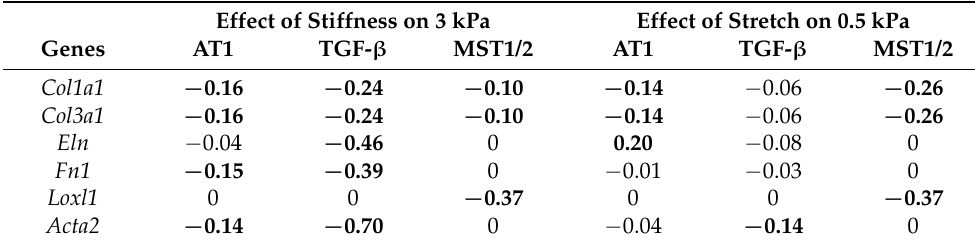
Table 2. Changes in gene expression due to inhibition of Angiotensin II Receptor Type I (AT 1 ), Transforming Growth Factor- β (TGF- β ), and Macrophage Stimulating 1 or 2 (MST1/2) receptors in response to stiffness and stretch. Numbers in bold indicate activity changes greater than a threshold of 0.1. Effect of Stiffness on 3 kPa Effect of Stretch on 0.5 kPa Genes AT1 TGF-